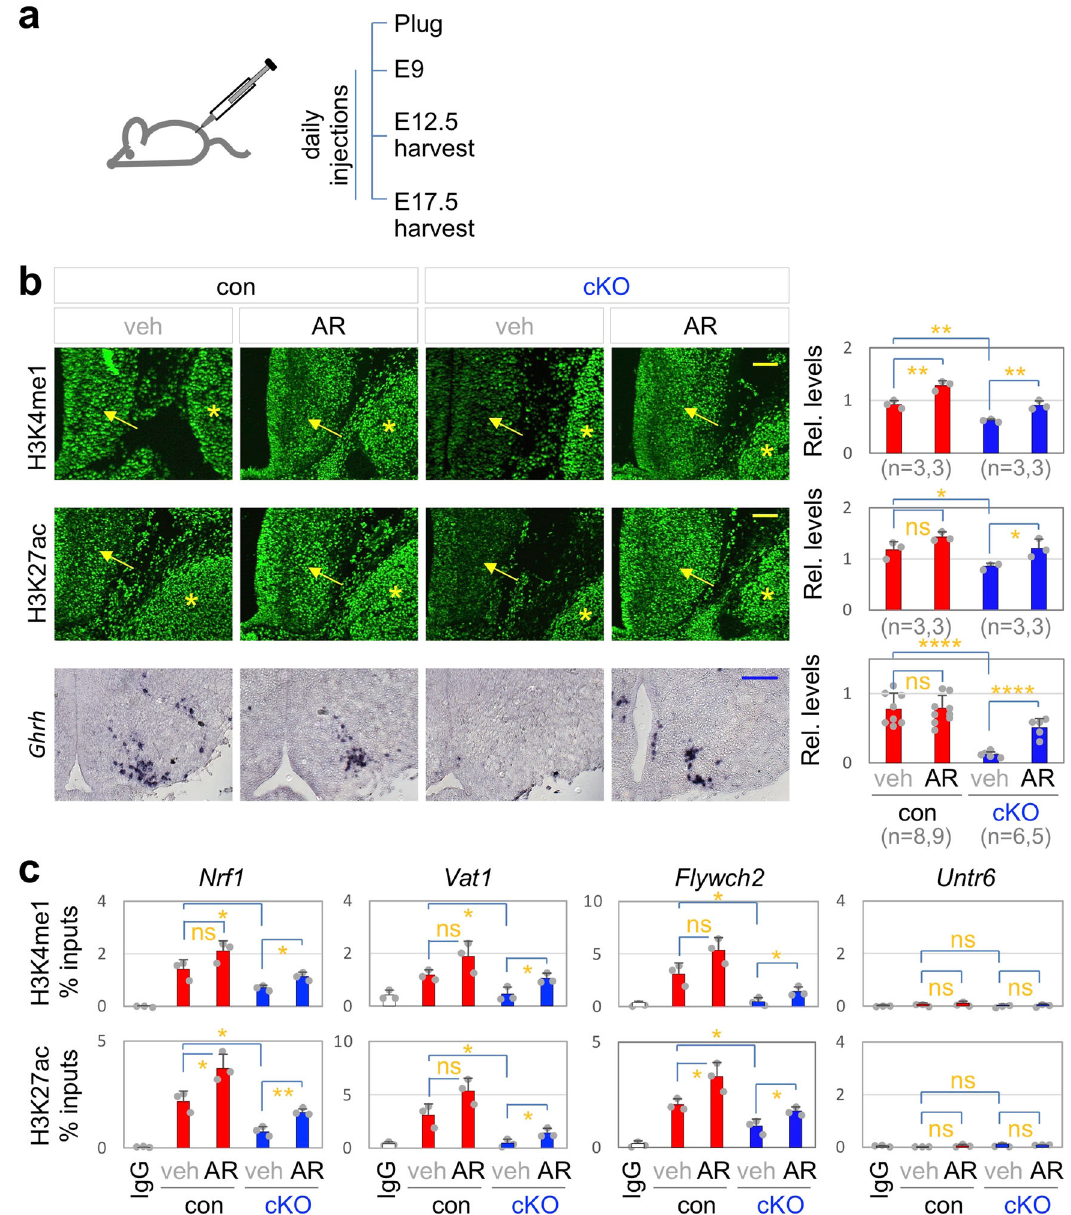
Fig. 7 AR-42 restores Ghrh expression in Mll4 -cKO mice. a Schematics for AR-42 experiments. From 9 days after a plug was observed, vehicle or AR-42 was injected to pregnant dams daily, followed by embryo harvests at E12.5 or E17.5. b IHC analyses of relative levels of H3K4me1 and H3K27ac in embryos harvested at E12.5 as well as ISH analyses of Ghrh expression in embryos harvested at E17.5. Quanti fi cation of H3K4me1/H3K27ac levels in the developing ARC (arrows) done relative to the signals in the adjacent tissues (the trigeminal ganglion, indicated by asterisks). The number of mice used is as indicated below each genotype in parenthesis. Scale bars, 100 µ m. c Embryos harvested at E15 ( n = 3, each genotype and condition) were subject to ChIP analyses with IgG (controls) or antibodies against H3K4me1 or H3K27ac, followed by qPCR quanti fi cation of H3K4me1/H3K27ac levels on genomic region containing the Mll4/Nrf1 ChIP-seq peaks associated with Nrf1 , Vat1 , Flywch2 , and Untr6 (negative control locus). Statistical differences were determined by two-sided Student ’ s t -test ( b , c ); * p < 0.05, ** p < 0.01, **** p < 0.0001, and not signi fi cant (ns). Column bars represent mean, error bars indicate the SD ( b , c